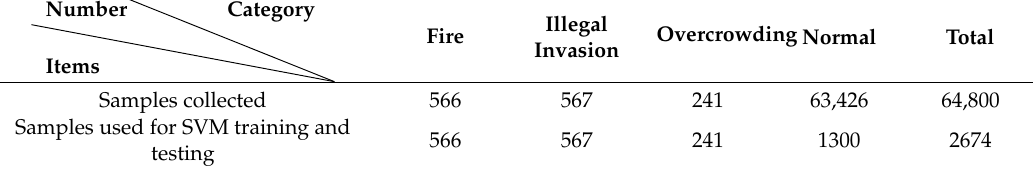
Table 3. Number of samples for di ff erent danger types.